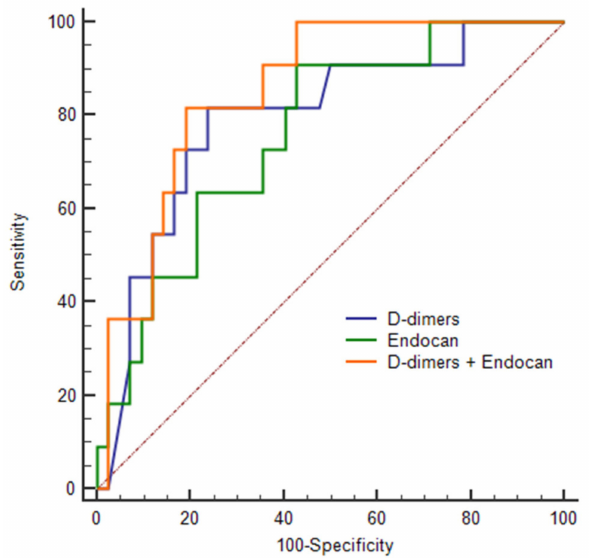
Figure 1. Receiver Operating Characteristic (ROC) curve for D-dimers and endocan to identify thrombotic events.